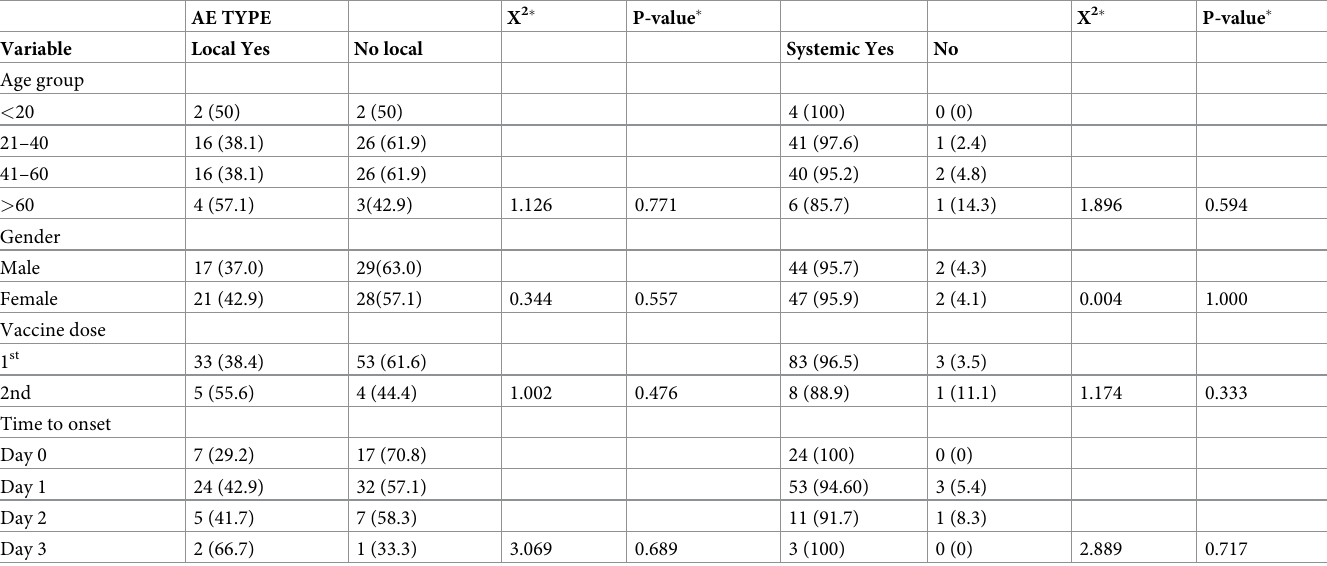
Table 4. Adverse event categories based on age, gender, dose, and time to onset.